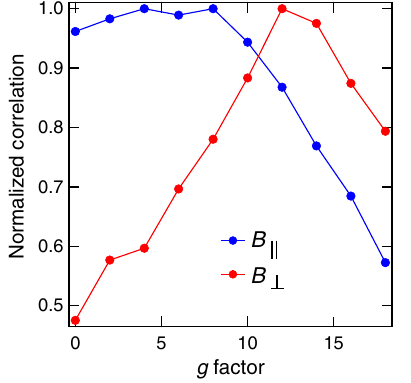
FIG. 8. Correlation (normalized to maximum value) between finite magnetic field data and theory as a function of the g factor, for field direction parallel (blue) or perpendicular (red) to the